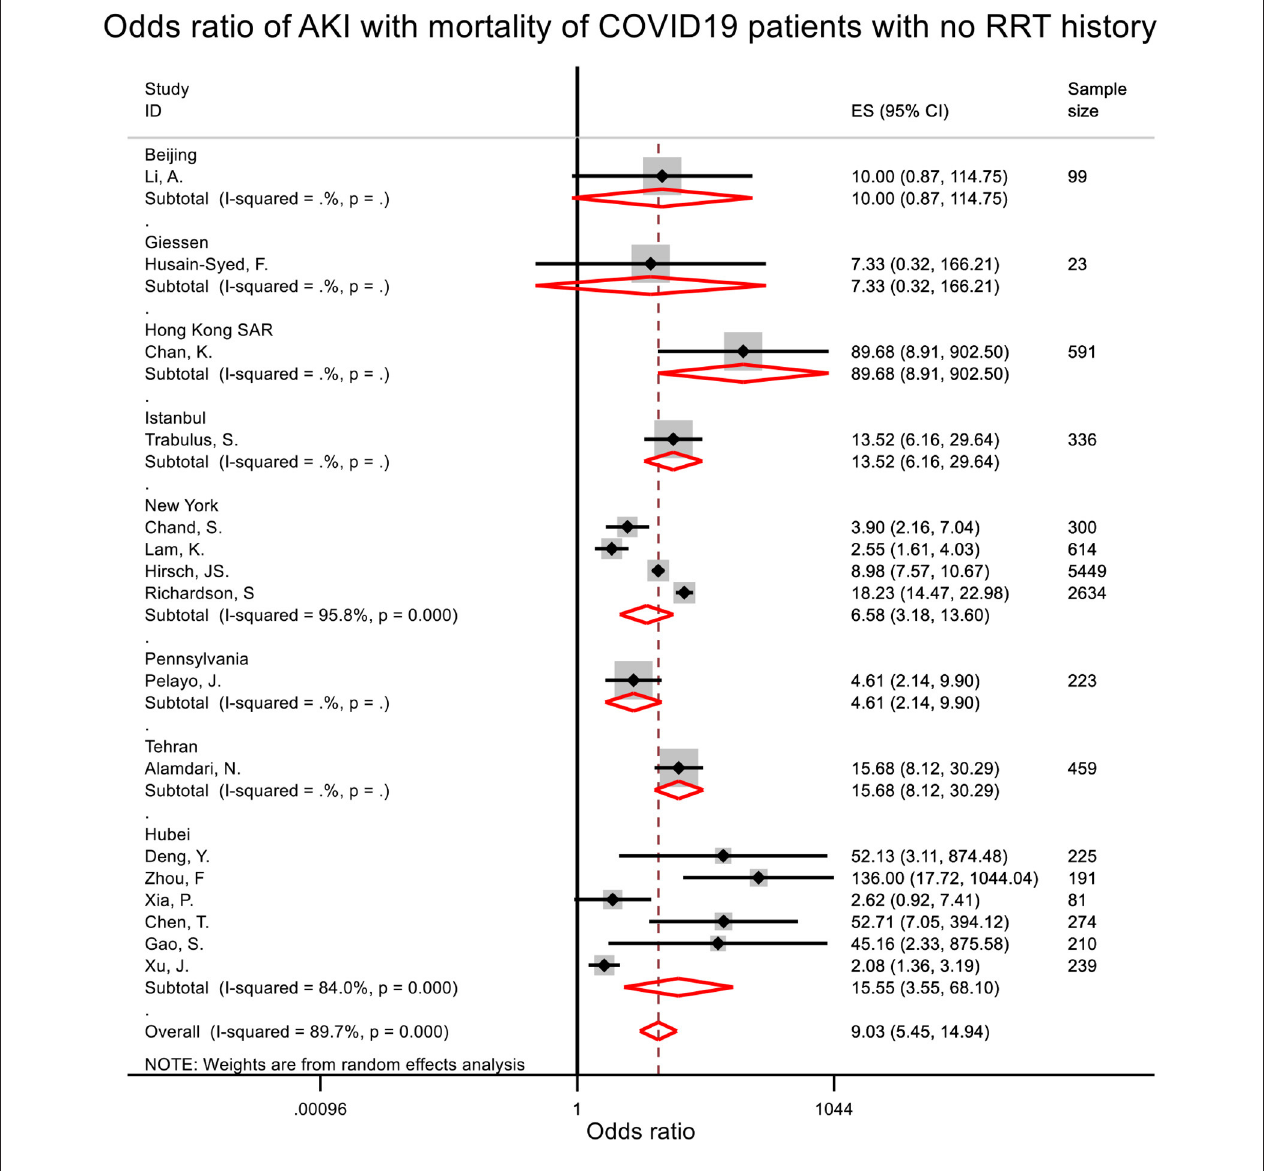
FIGURE 3 | Odds ratio of acute kidney injury with mortality among patients with no renal replacement therapy history. Patients who developed AKI during hospitalization were associated with 8-times increased odds of death.